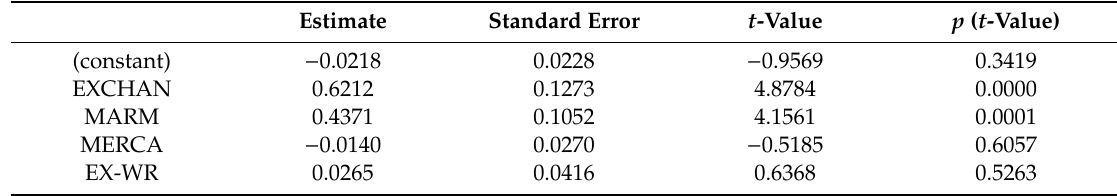
Table A3. Regression coe ffi cients for the model of the field prices of mandarins without considering the time (MONTH), AREA, or variety (VAR) variables.